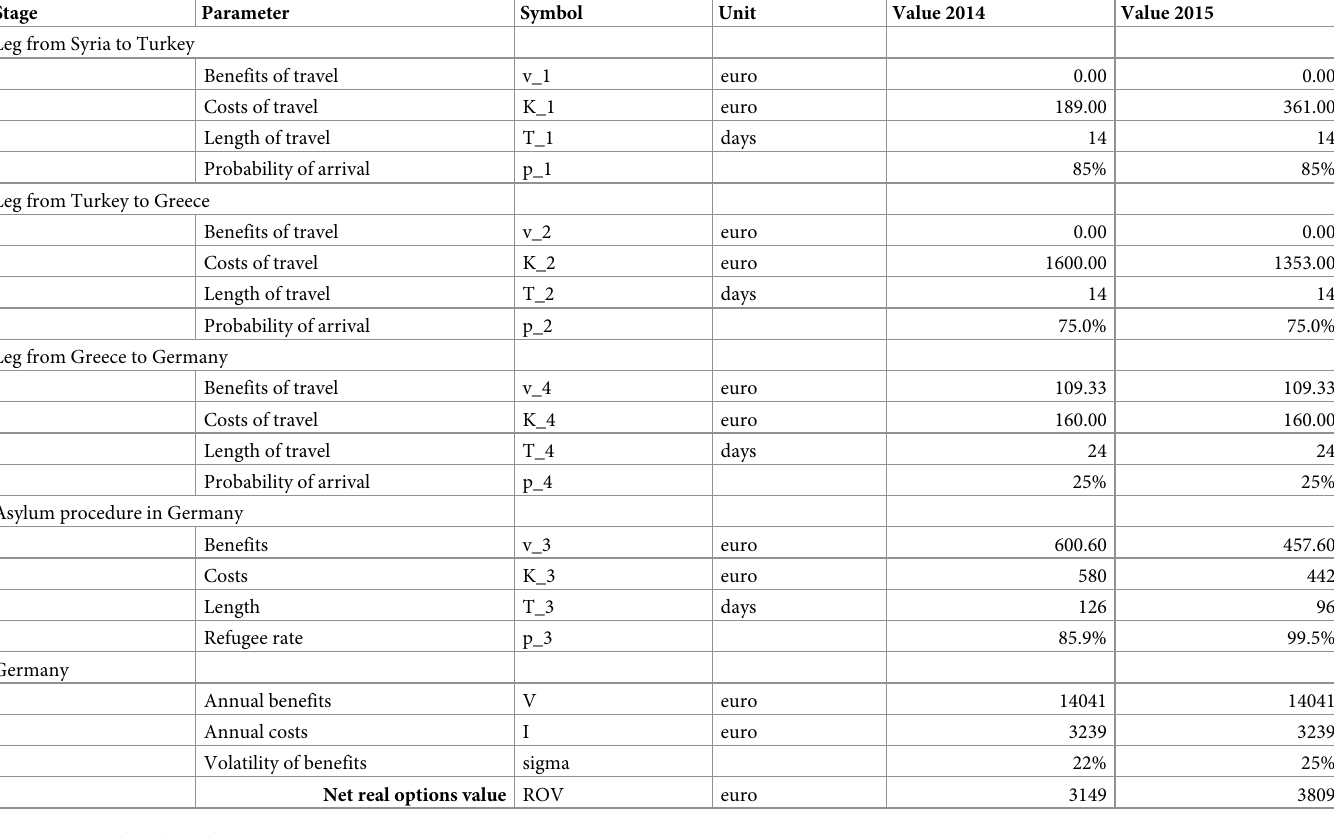
Table 2. Value drivers and real options value for Eastern Mediterranean Route by sea in 2014 and 2015. Stage